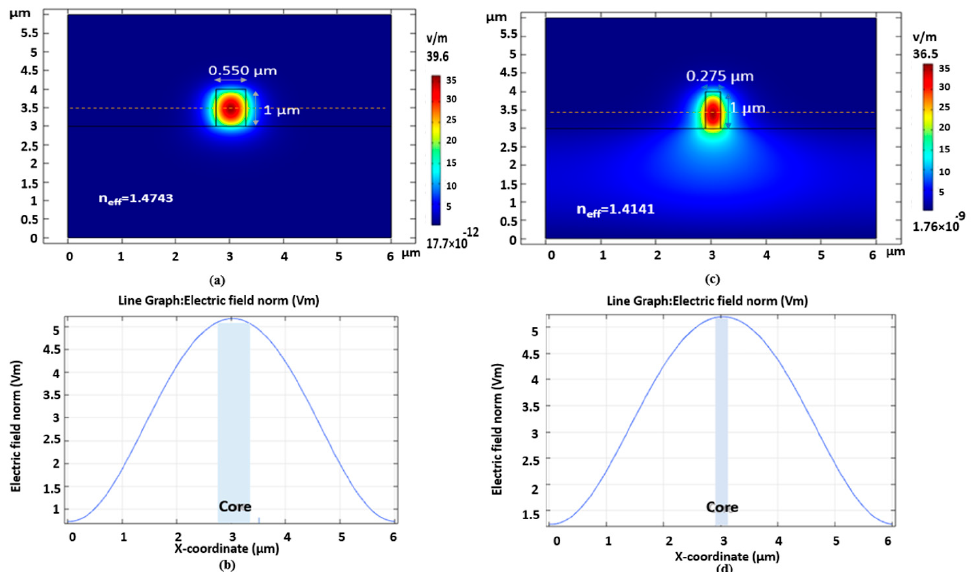
Figure 3. Mode profile, normalized E − field distribution of the TE fundamental mode, and the cal- culated effective index in the strip waveguide parts ( a , b ) and tapered parts ( c , d ). Each tapered part’s angle section was equal to 15°, or π 12⁄ . The effective index